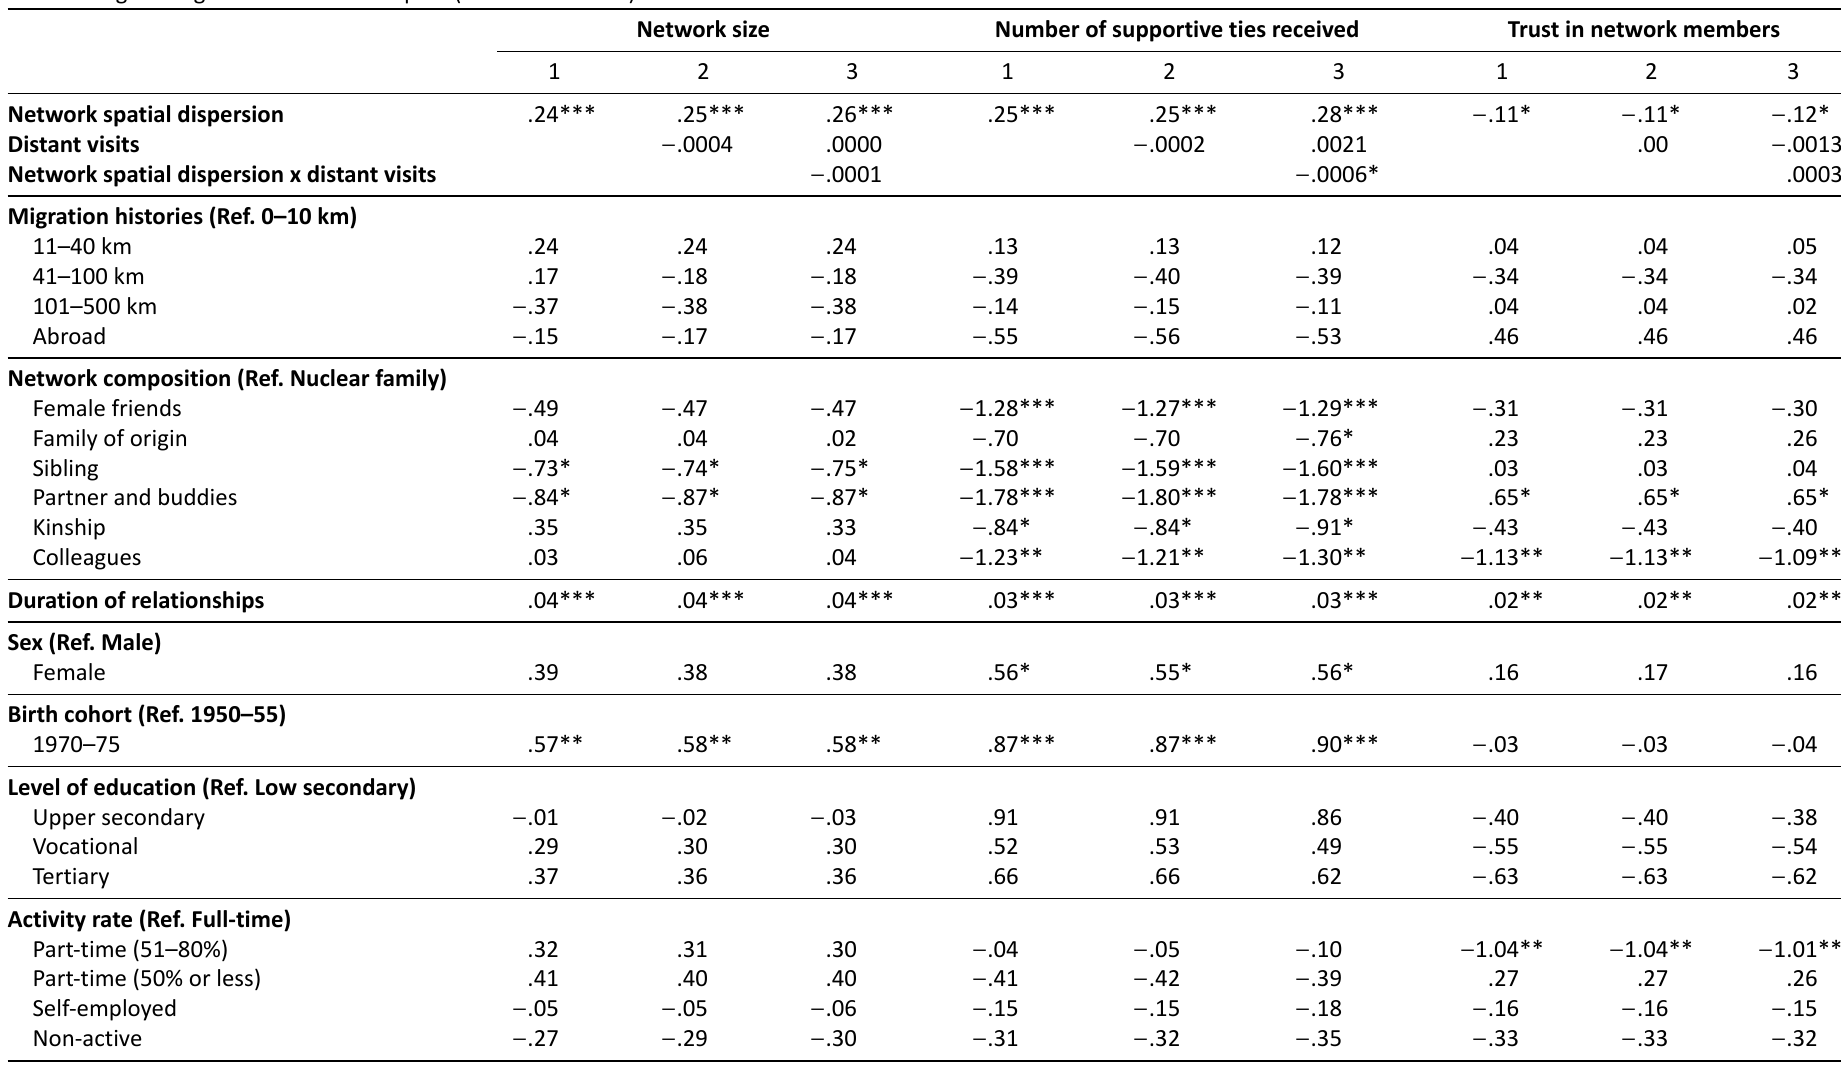
Table 2. Logistic regressions of social capital (beta